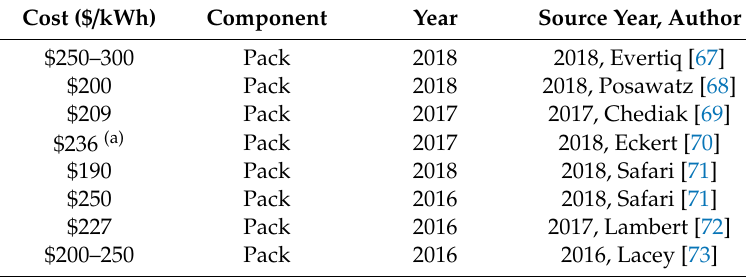
Table 12. Lithium-ion EV battery costs, 2016–2018.